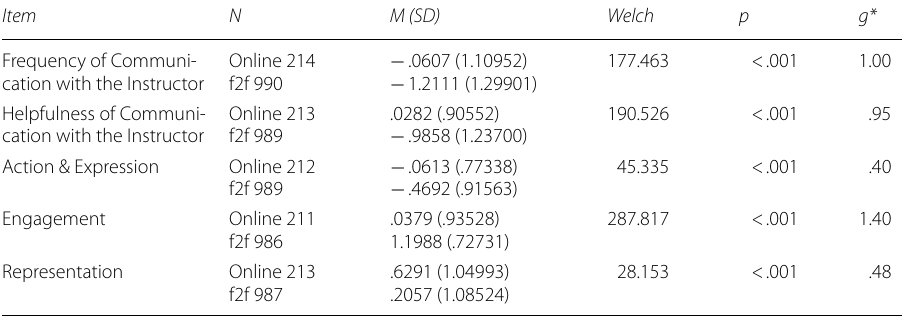
Table 2 Comparison of gains scores between students who preferred online instruction versus those who preferred face-to-face (f2f) instruction for quality of instruction before and after the shift to remote learning